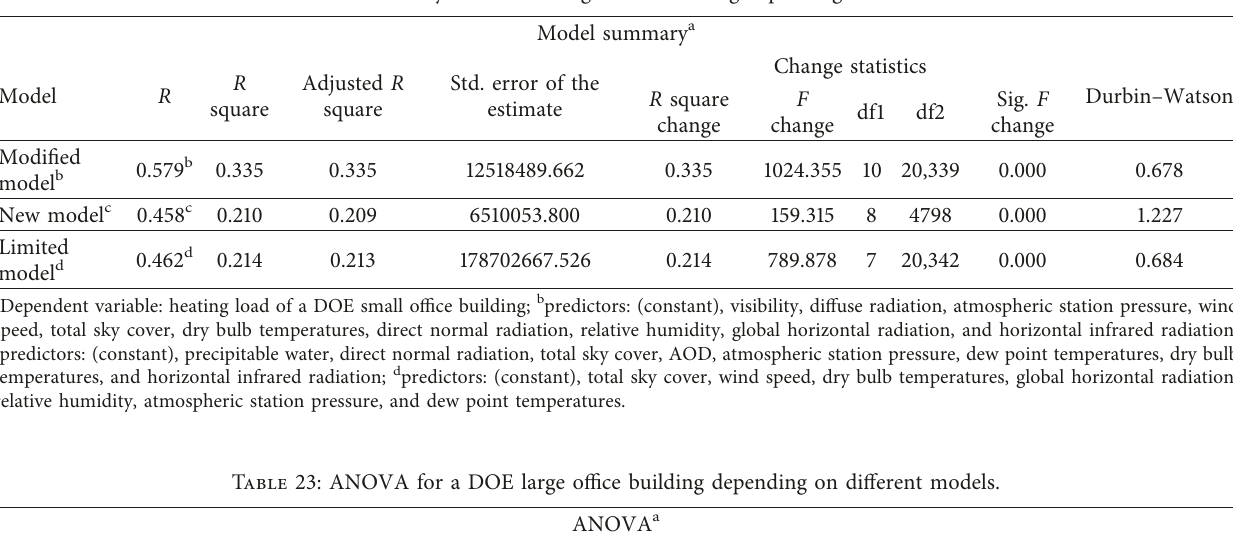
Table 22: Model summary for a DOE large office building depending on different models.